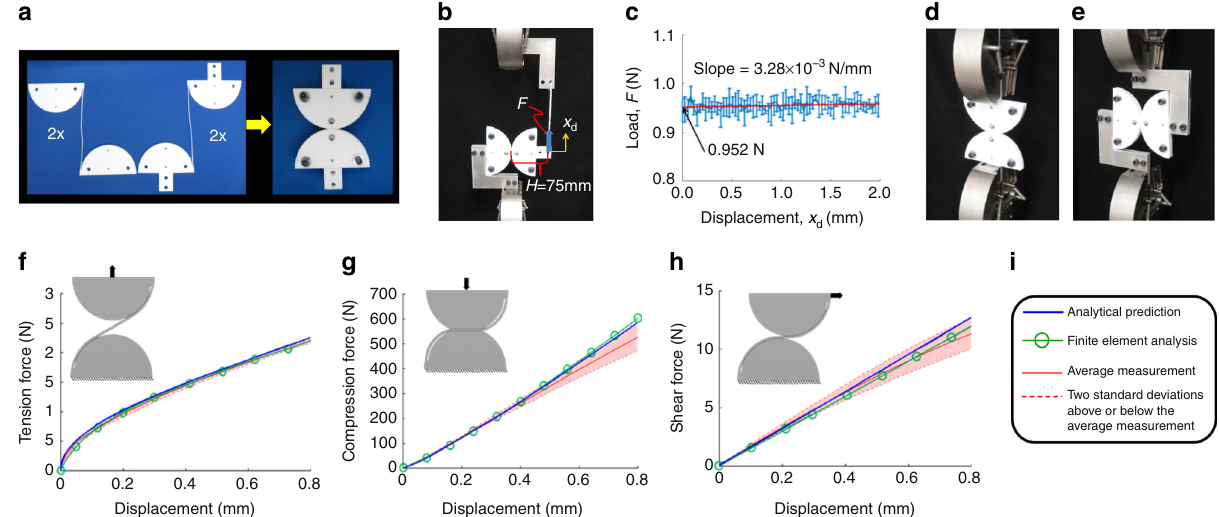
Fig. 6 Experimental validation. a Fabricated four-layer compliant rolling-contact joint (CRJ). b Test set-up for measuring the angular stiffness of the CRJ and c results collected from fi ve sets of data. Test setup for d tension, compression, and e shear. Finite element analysis (FEA) veri fi cation and experimental validation of the four-layer CRJ in f tension, g compression, and h shear. i Plot key